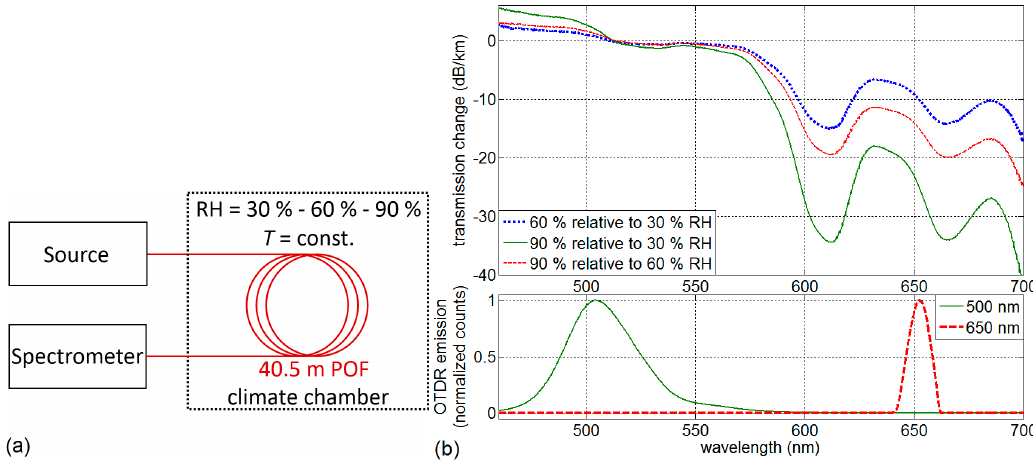
Figure 2. ( a ) Schematic of the transmission change measurement setup; ( b ) spectral transmission changes of PMMA POF (upper plot) and measured OTDR emission spectra (lower plot).